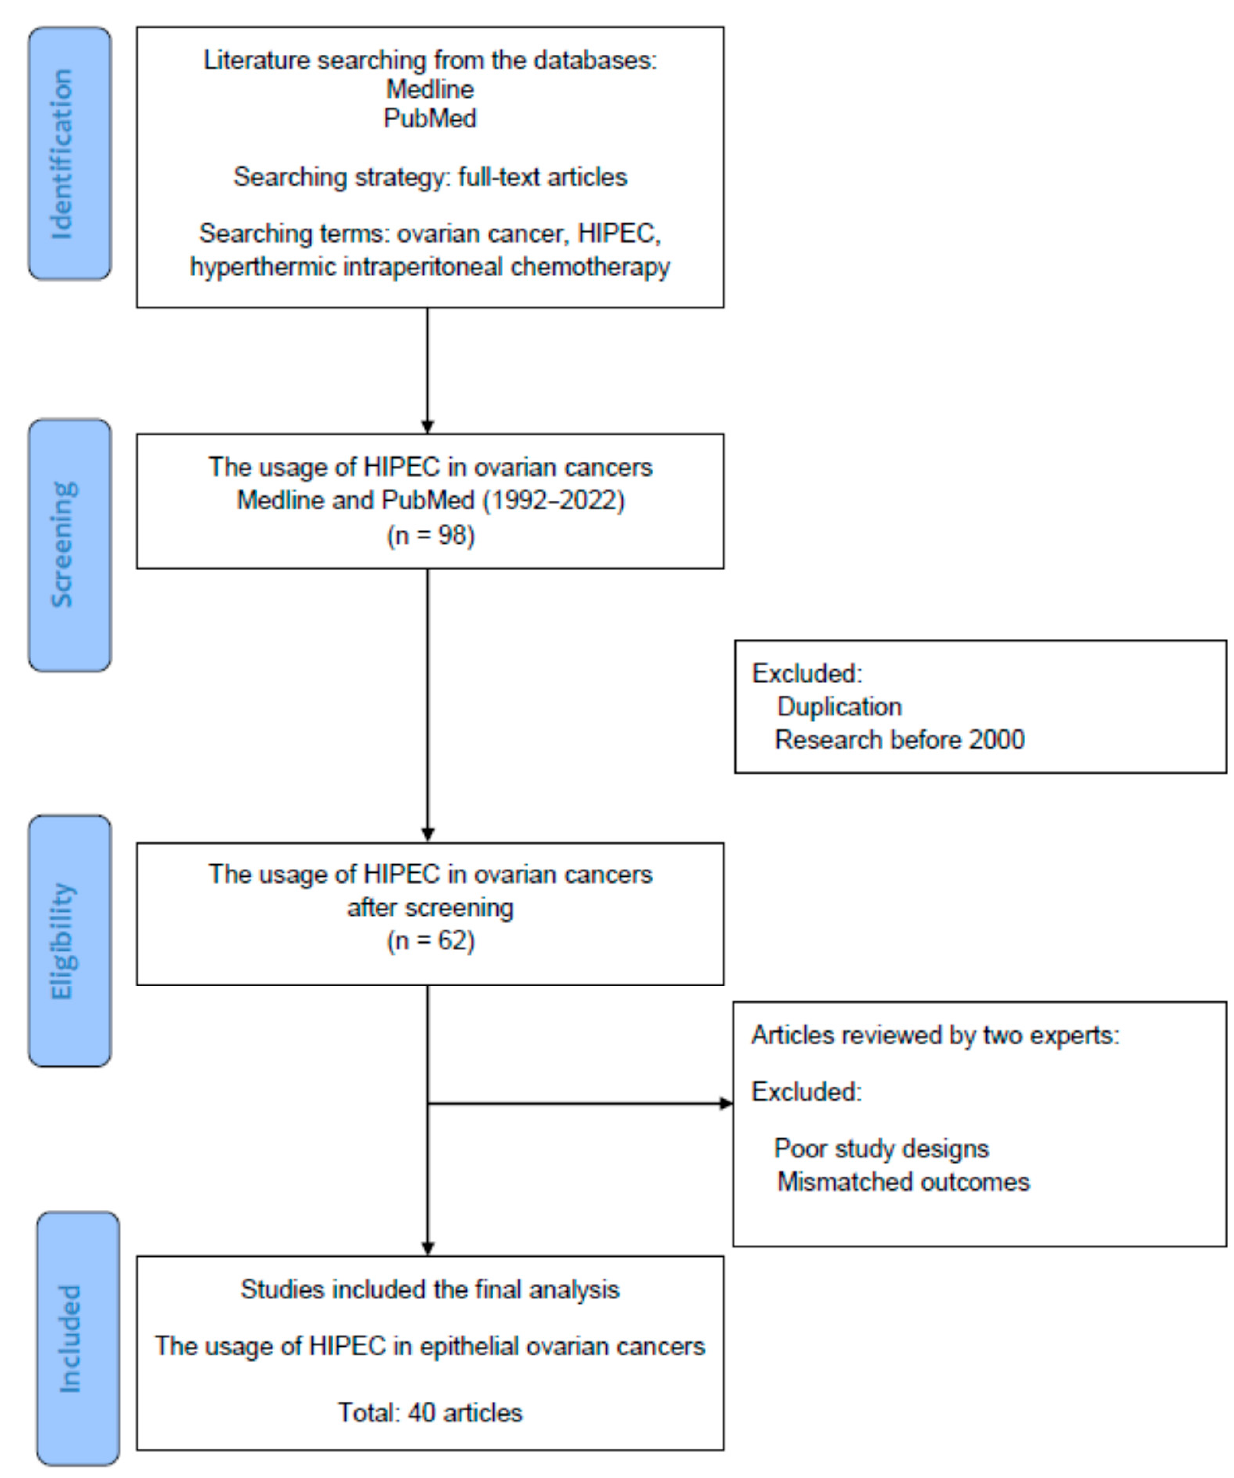
Figure 1. The diagram of article selection, screening and inclusion from the literature.